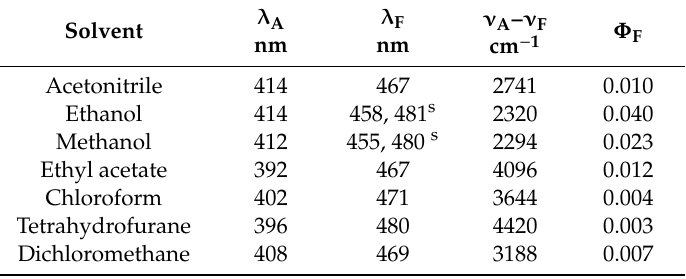
Table 1. Photophysical characteristics of ACR dendrimer in organic solvents of different polarity (see text).